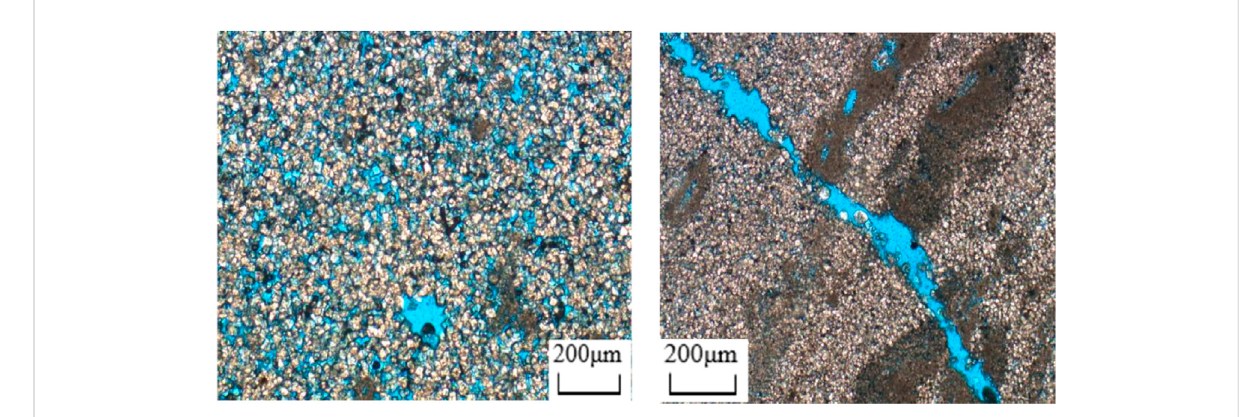
FIGURE 1 Thin section of the cast.